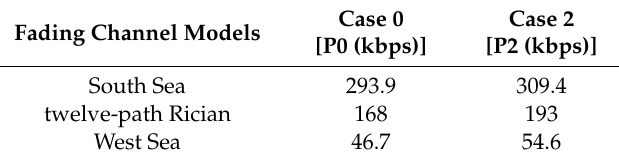
Figure 10. Throughput performance comparison for PA case 0: P0 versus PA case 1: P2. Table 5. Throughput comparison at 50% cumulative distribution function